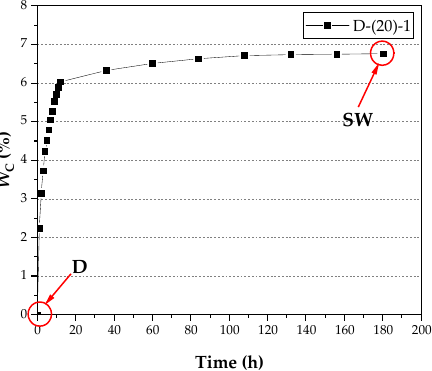
Figure 3. Variation of moisture content with immersion time. The mass loss rate, appearance, and relative dynamic elastic modulus after freeze-thaw cycles are shown in Figure 4.